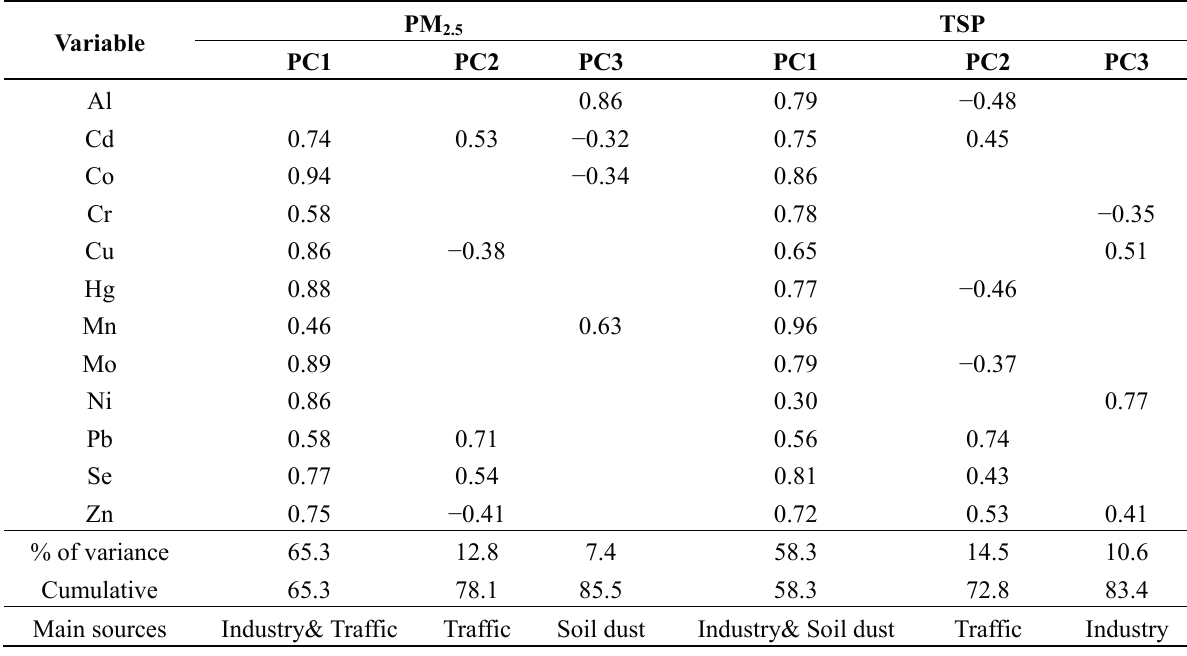
Table 3. Rotated factor loading of trace metals in PM Dafushan forest park. The principal components loading with absolute values greater than 0.3 were